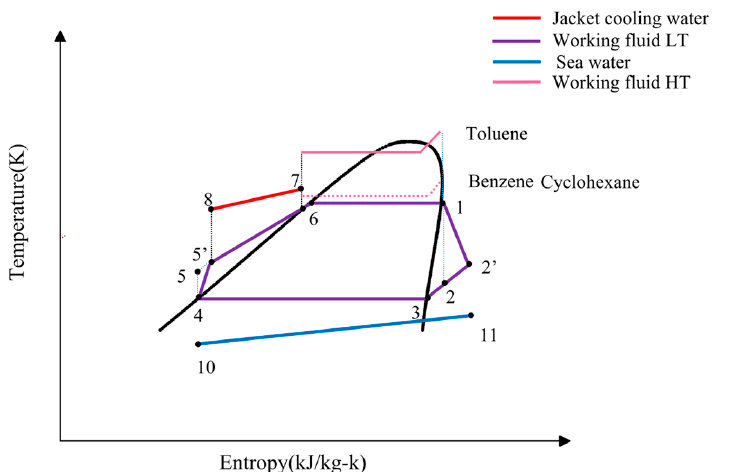
Figure 9. T-s diagram of the LT loop in case b.